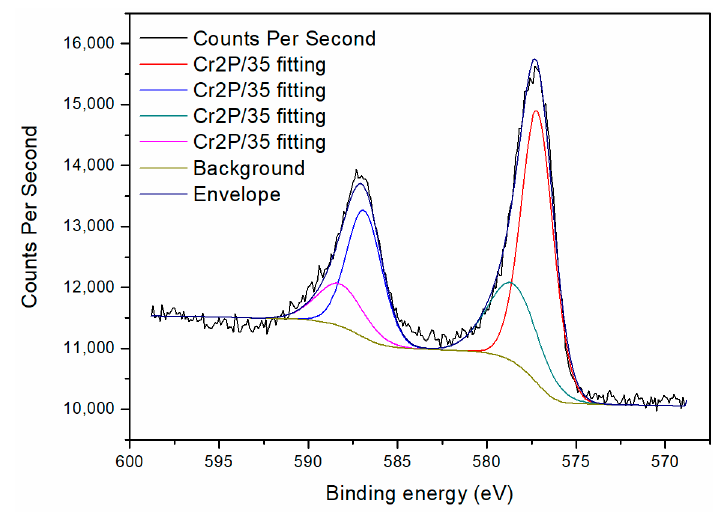
Figure 6. XPS Cr2p spectra of cathode treatment products by MFCs equipped with pyrrhotite-coated cathode (Cr (VI) initial concentration of 30 mg/L and pH of 3.0).